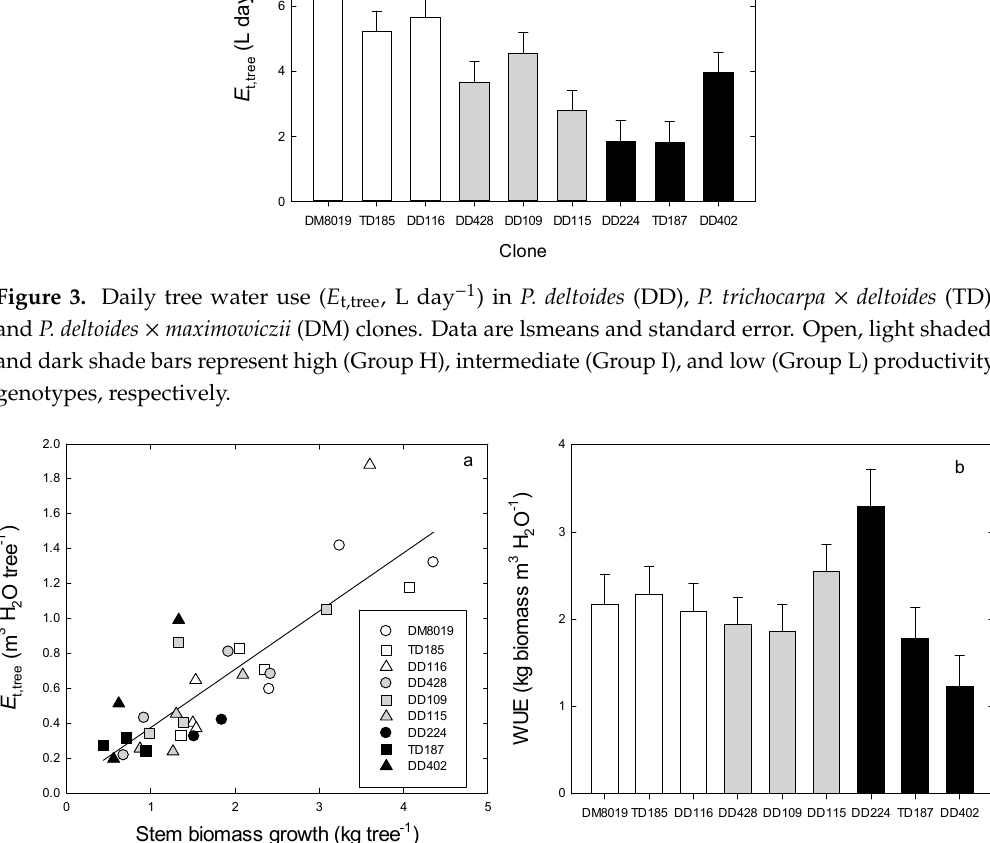
Figure 4. Relationship between total tree water use ( E t,tree , m 3 H 2 O tree − 1 ) and stem biomass growth ( a ) and the mean (lsmeans ± SE) water use efficiency of production (WUEp) ( b ) in P. deltoides (DD), P. trichocarpa x deltoides (TD), and P. deltoides x maximowiczii (DM) clones. Open, light shaded, and dark shade bars represent high (Group H), intermediate (Group I), and low (Group L) productivity genotypes, respectively.